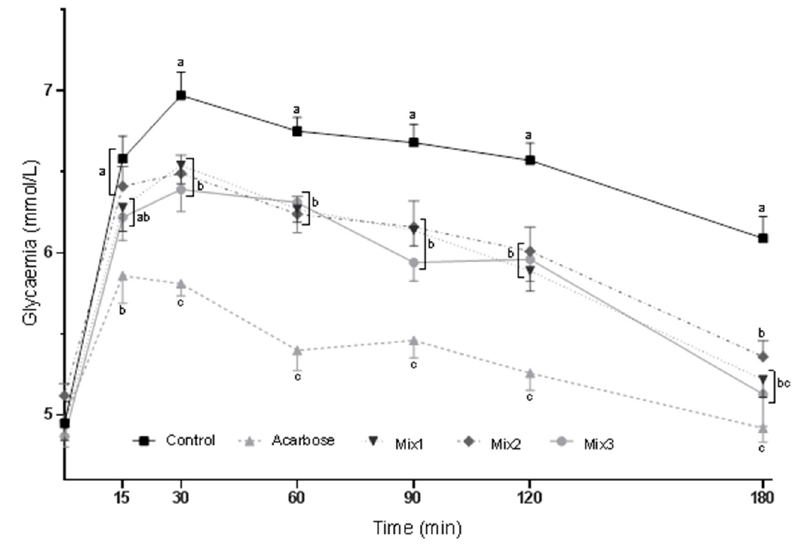
Figure 2. Blood glucose curves for the oral starch tolerance test (StTT) in rats gavaged with acarbose or composed mixtures. Values are expressed as the mean ± SEM ( n = 12). Mean values with differing letters within a time period (a, b, c) are significantly different at p < 0.05 in a post hoc test. BW, body weight. Composition and doses (mg/kg BW): Mix1—mulberry leaf extract (120 mg) + kidney bean extract (100 mg) + coffee bean extract (20 mg); Mix2—mulberry leaf extract (120 mg) + coffee bean extract (20 mg) + arabinose (25 mg); Mix3—mulberry leaf extract (120 mg) + kidney bean extract (100 mg) + coffee bean extract (20 mg) + arabinose (25 mg).